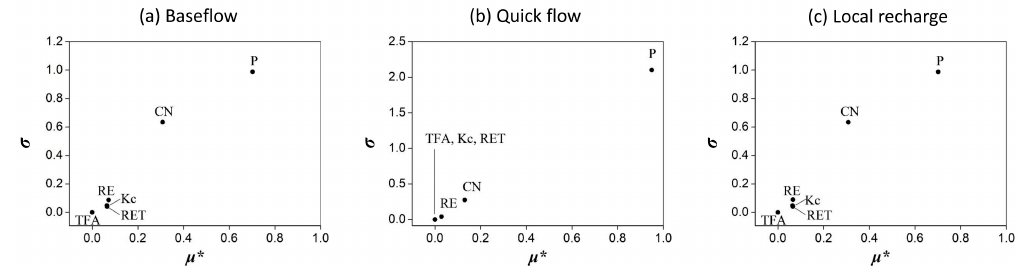
Figure 2. Morris screening results: µ * indicates the importance and σ the degree of non-linearity or interaction caused by each factor for ( a ) baseflow, ( b ) quick flow and ( c ) local recharge: precipitation (P), curve number (CN), rain events (RE), crop/vegetation coefficient (Kc), reference evapotranspiration (RET), and threshold flow accumulation (TFA).